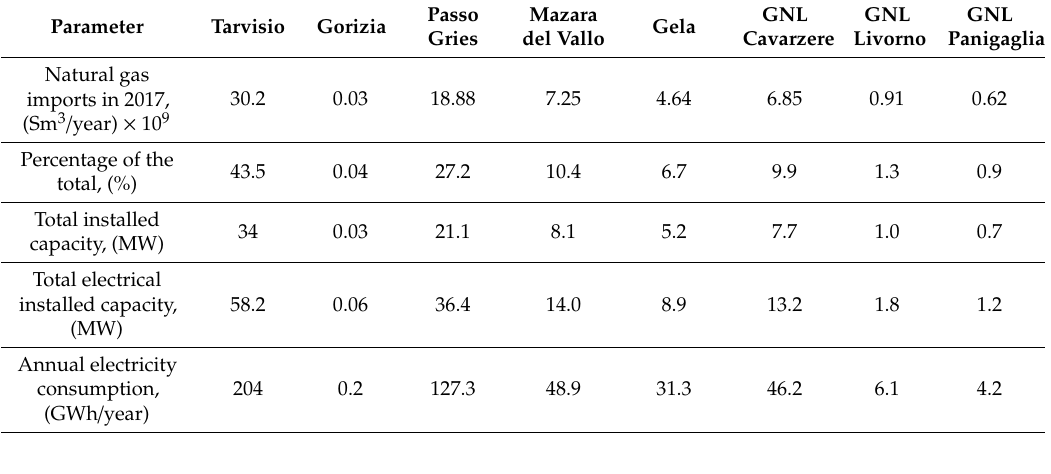
Table 10. Preliminary estimation of Italian P2H plants’ total size.